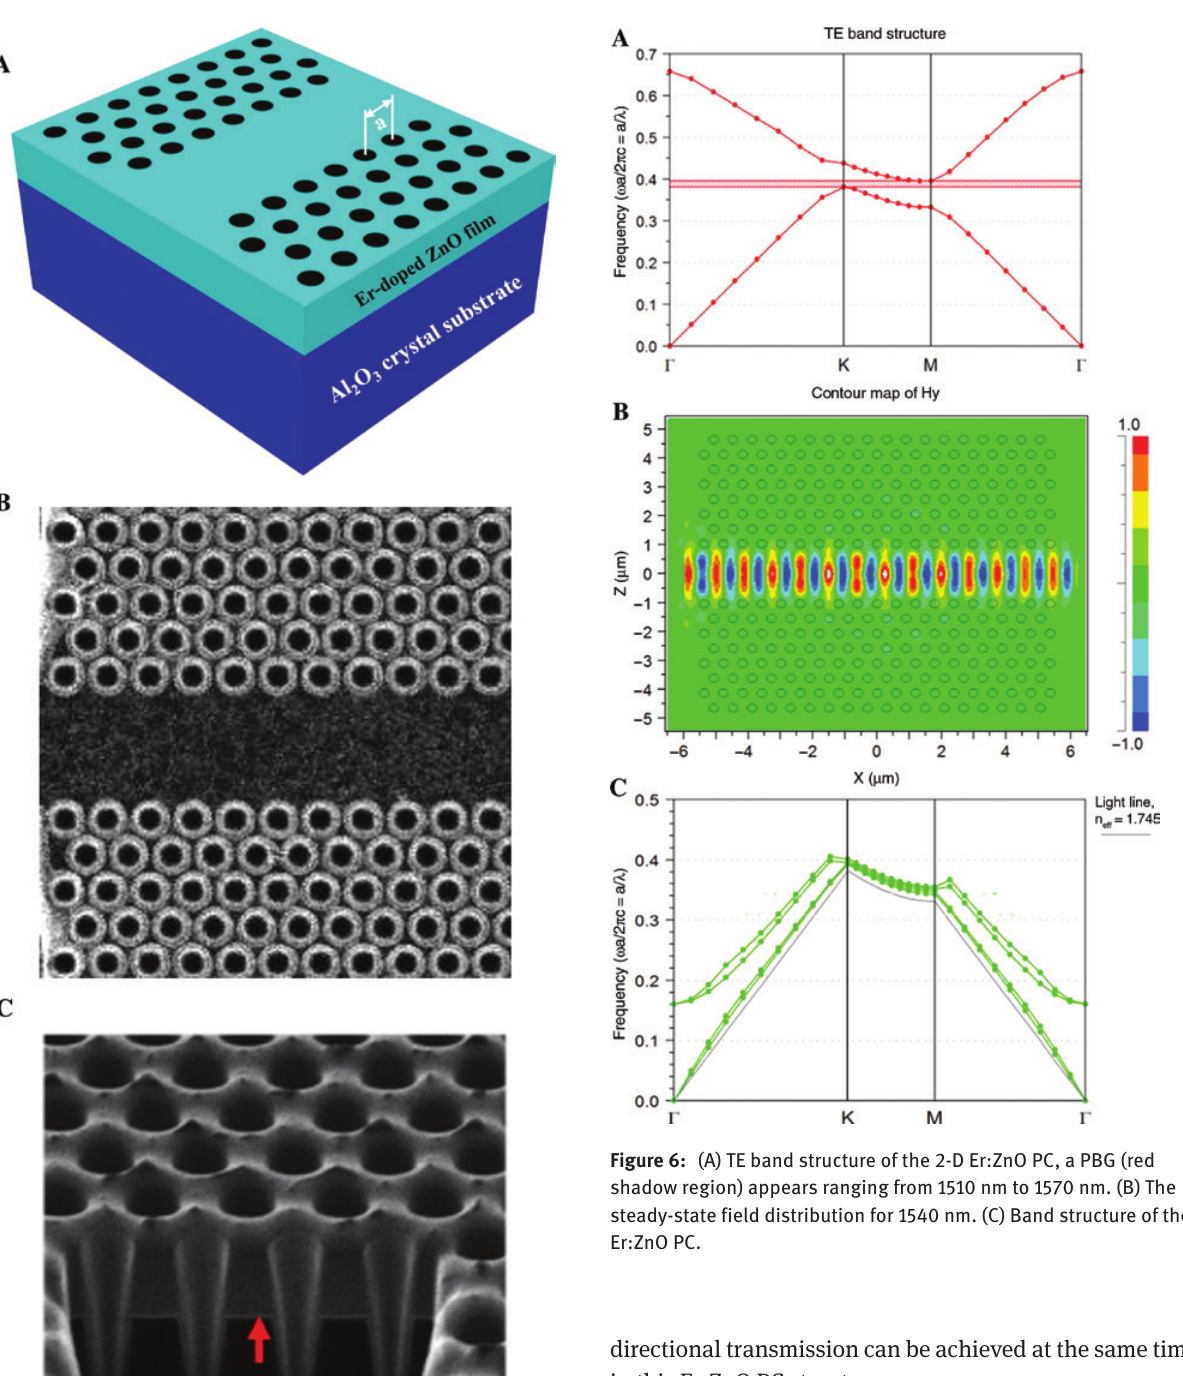
O substrate (blue), and 2 3